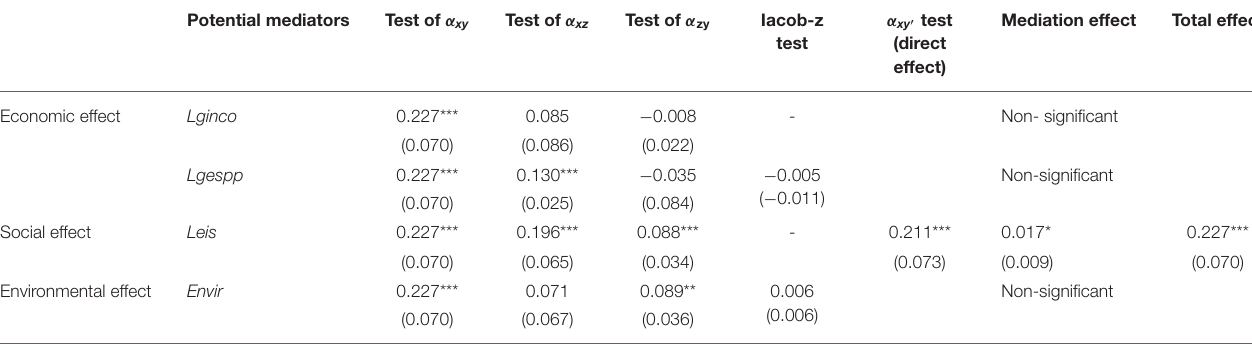
TABLE 3 | Testing results and decomposition of the mediation effect of energy consumption revolution on improving farmers’ happiness.